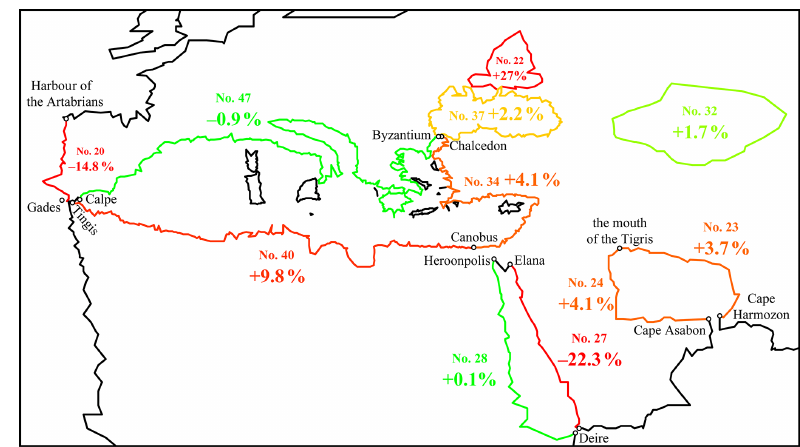
Figure 2. Differences between the coastline lengths as derived from Ptolemy’s coordinates and as given by Artemidorus (including those that he has inherited from Timosthenes and Eratosthenes: nos. 20, 22–24, 27–28, 32, 40, 46–47 in Table 1). The percentages refer to the deviation of Ptolemy’s values from those of Artemidorus. The outlines are drawn according to the (cid:52) recension supplemented with coordinates from (cid:127) for the areas of Asia that are missing in (cid:52) .